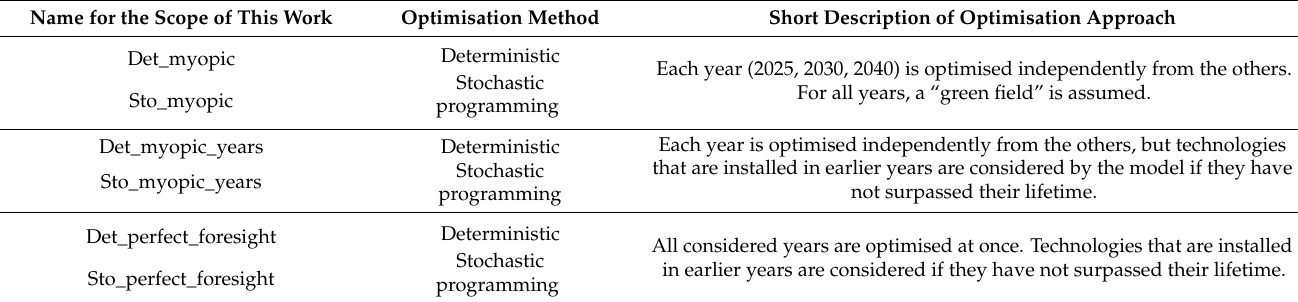
Figure 4. Defined scenarios with uncertain CO 2 prices as well as energy carrier costs. Table 5. Overview on the optimisation approaches.